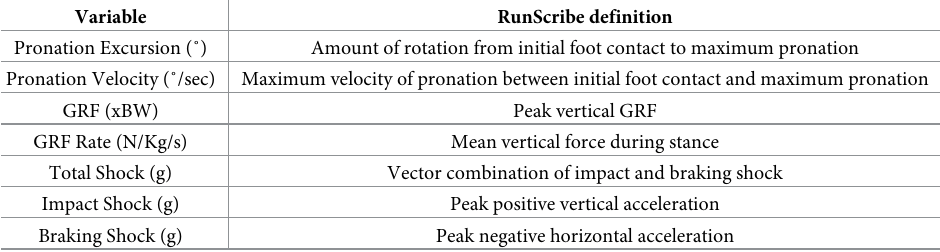
Table 1. Definition of variables measured by the RunScribe Plus